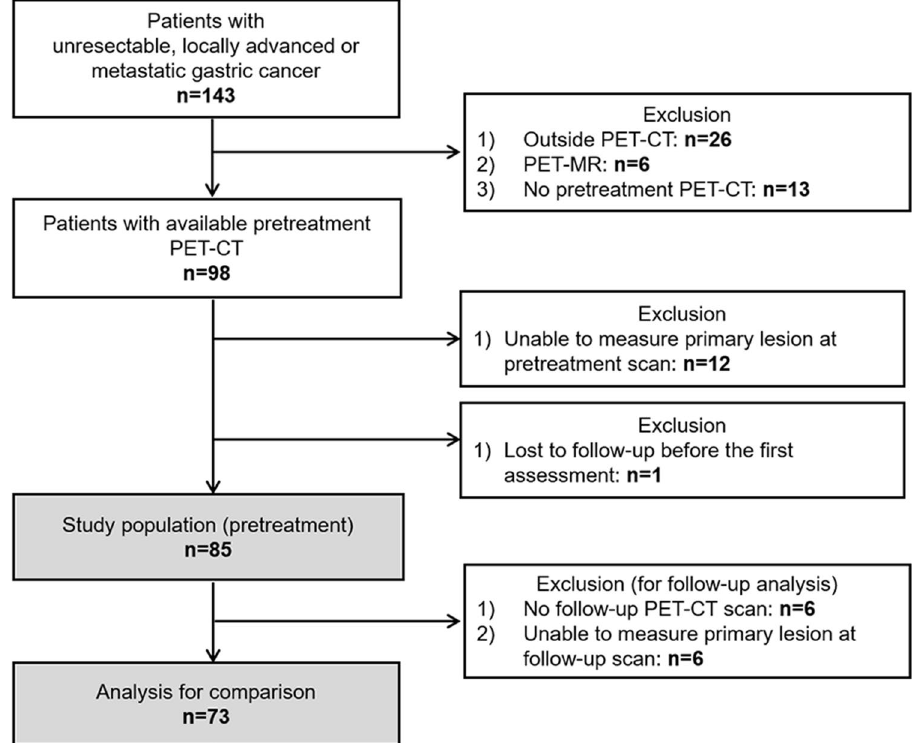
Figure 1. Flow chart of study participant